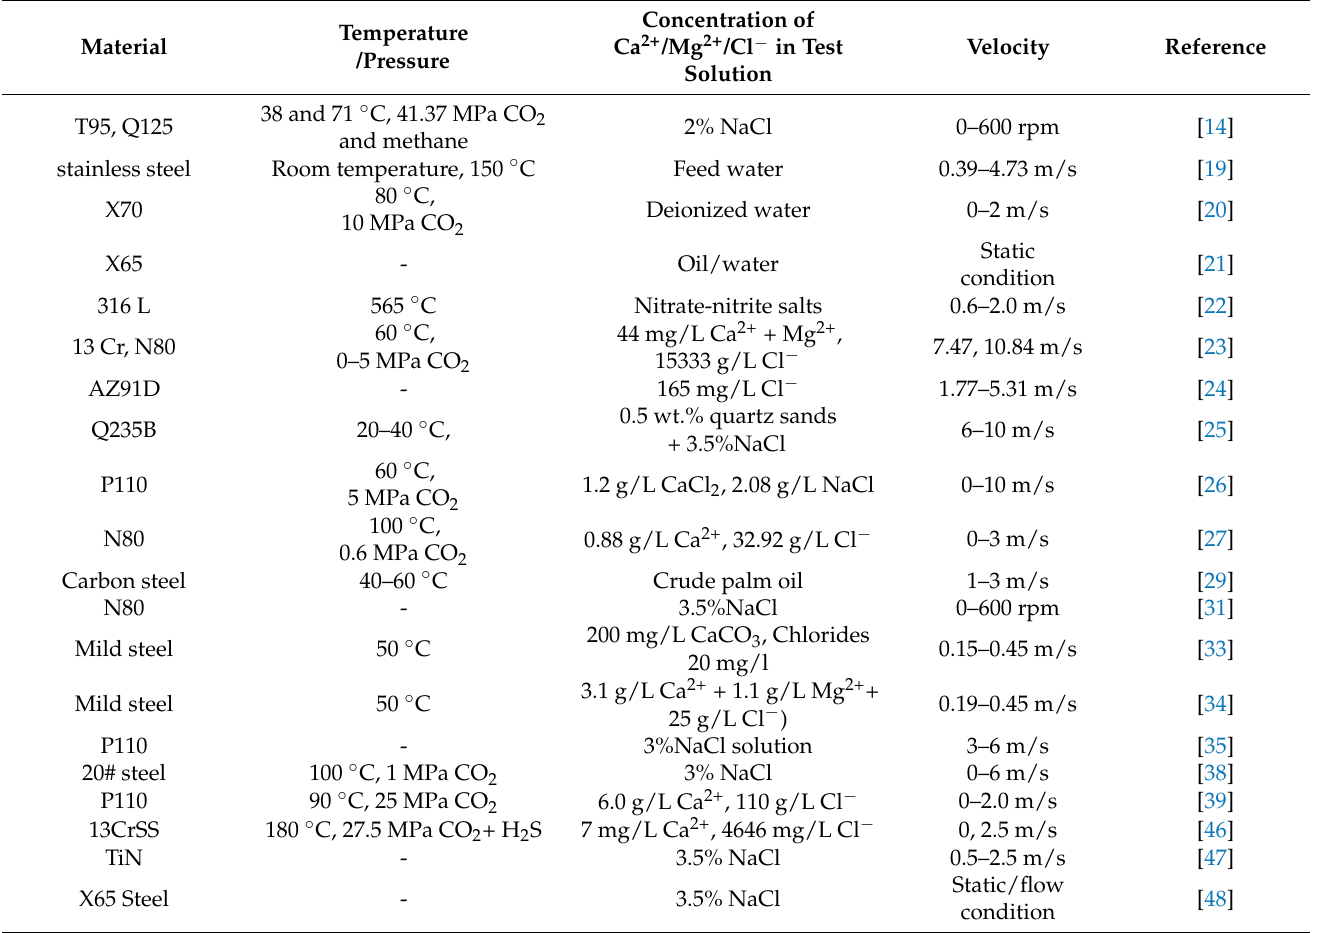
Table 1. The investigation of flow rate on the corrosion behavior of metal.